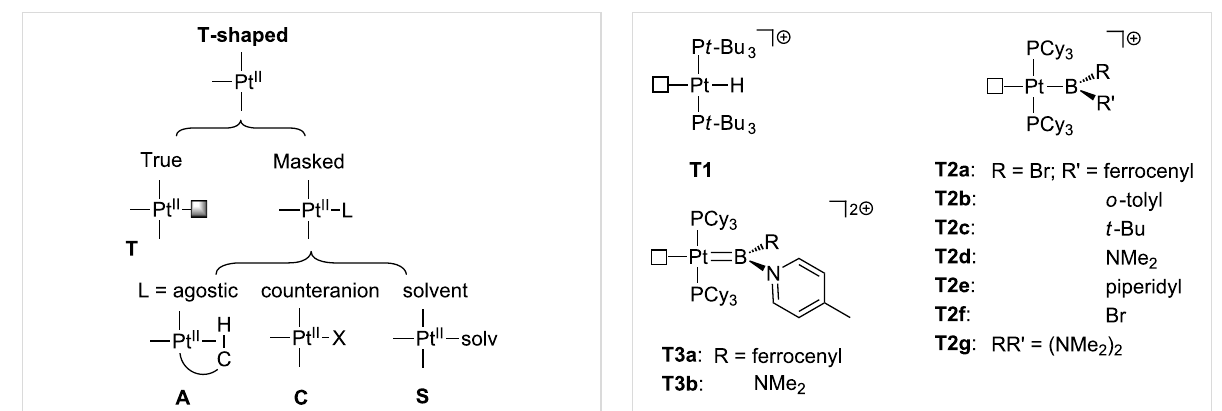
Figure 4: General classification of T-shaped Pt(II) structures according to the fourth coordination site. True T-shaped